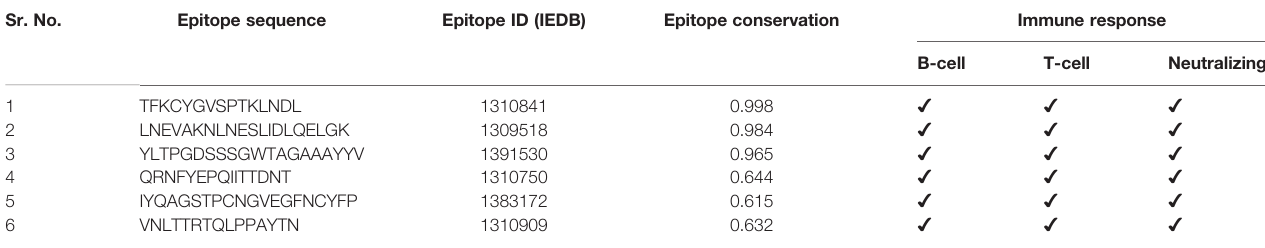
TABLE 2 | Conservation of CCN epitopes in all strains of SARS-CoV-2. Sr. No.